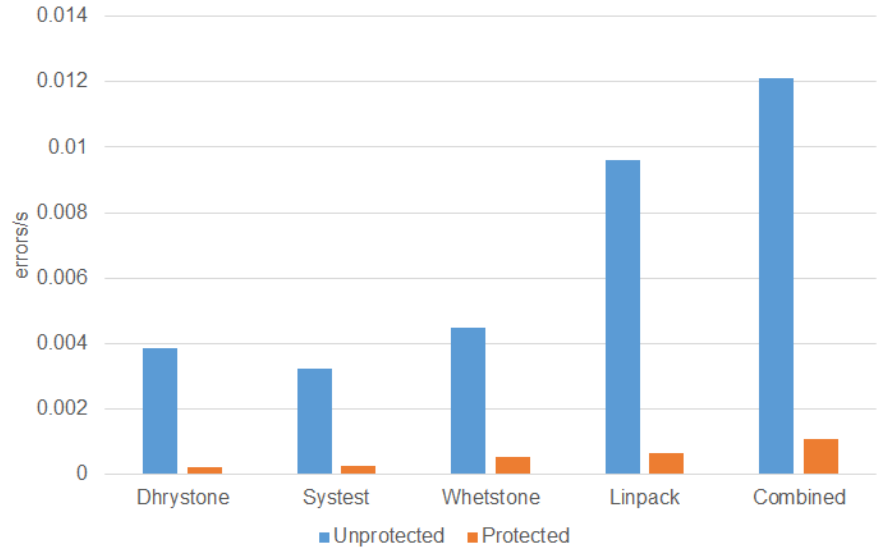
Figure 2. Comparison between unprotected and protected designs in terms of errors per